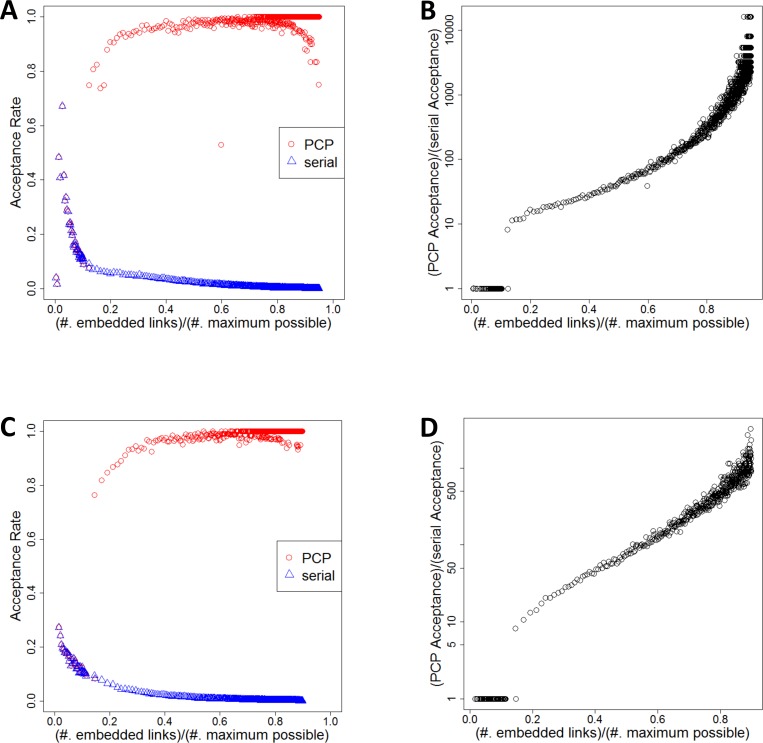
Comparison of acceptance rates of correlation pairs into PFN links.A,B) Results from PFN construction from TCGA lung squamous cell carcinoma (LUSC) data including 20523 genes. 57562 links out of maximal possible link number of 61563 are embedded. The left panel (A) shows the acceptance rates without PCP (denoted as “serial”, and colored as blue), and after performing PCP (denoted as “PCP”, and colored as red), as a function of number of links already embedded on the PFN, normalized by the maximum possible number of embedded links. The right panel (B) shows the ratio of acceptance rates after PCP to the acceptance rates without PCP is plotted as a function number of links already embedded on the PFN, normalized by the maximum possible number of embedded links. C,D) Results from TCGA thyroid carcinoma (THCA) data including 16639 genes. 44802 out of maximal possible link number of 49911 are embedded. The right and left panel show the same plots as described in the case of LUSC.